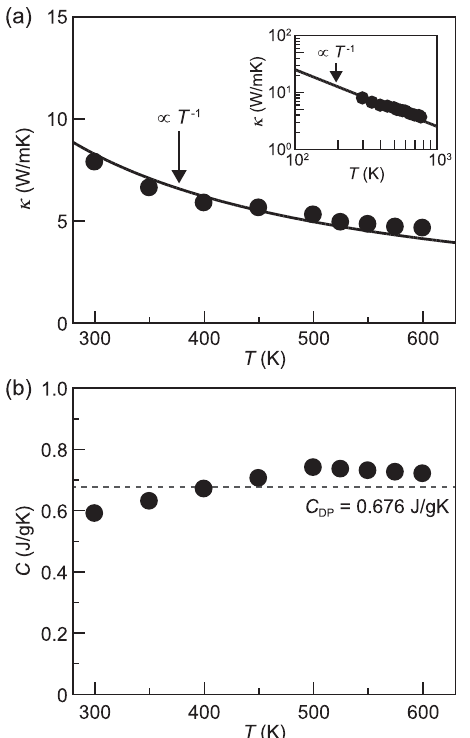
5. (a) T dependence of the thermal conductivity κ of the YIG slab. The black circles show the measured thermal conduc- tivity and the black curve shows the fitting of the experimental data with κ ¼ KT − 1 , where K is an adjustable parameter. The inset shows the double logarithmic plot of the T dependence of κ . (b) T dependence of the specific heat C of the YIG slab. The gray dotted line shows the DP specific heat of